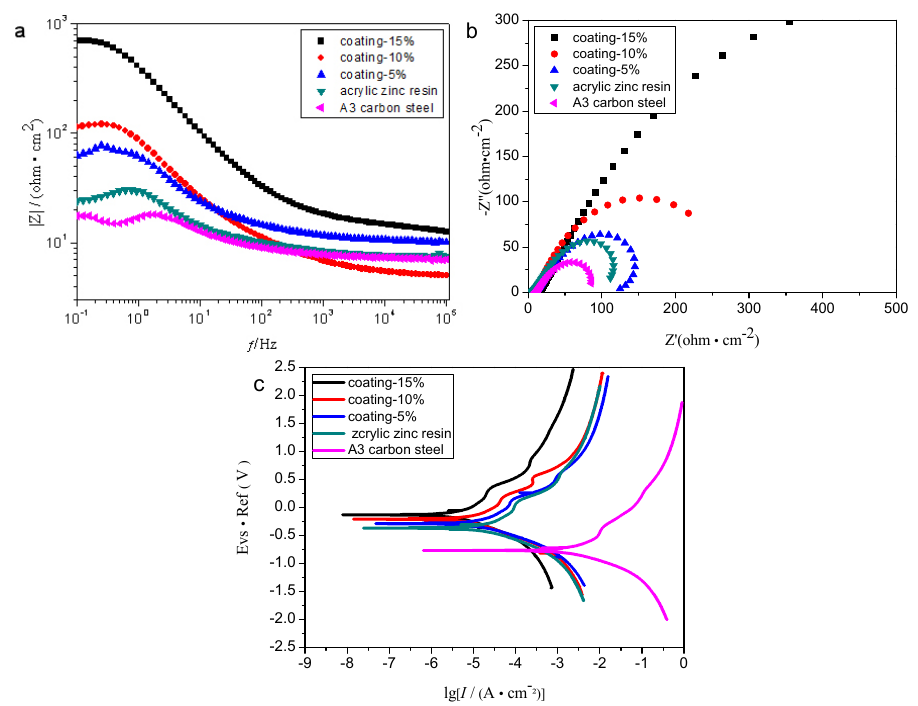
Figure 11. Electrochemical performance of the coatings: ( a ) EIS Bode plots; ( b ) EIS Nyquist plots, and ( c ) potentiodynamic polarization curves of the coatings in seawater.